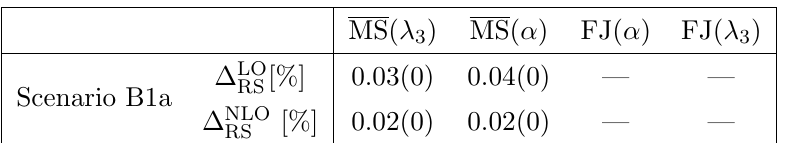
Table 6 . The variation (cid:1) RS of the h ! 4 f width in scenario B1a at the central scale (cid:22) 0 using the reliable renormalization schemes MS( (cid:21) 3 ) and MS( (cid:11) ) (with NLO parameter conversions). The columns correspond to the schemes in which the input parameters are de(cid:12)ned. Using parameters de(cid:12)ned in the FJ( (cid:11) ) and FJ( (cid:21) 3 ) schemes, the results are unreliable and a computation of (cid:1) RS is not meaningful. The zeroes in brackets show that the integration errors are